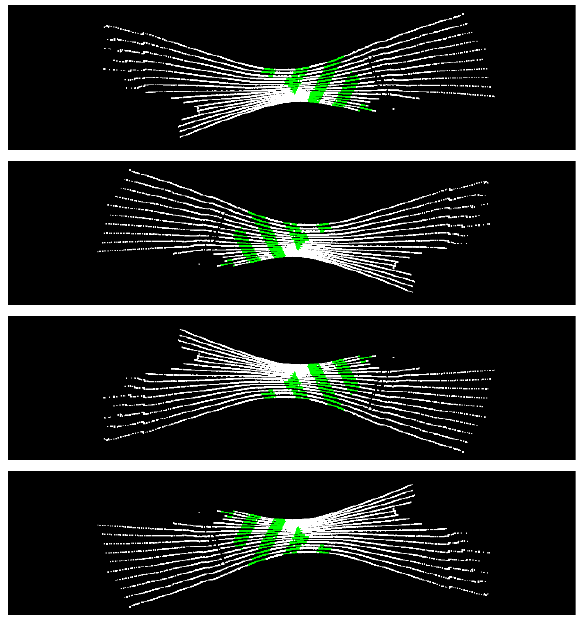
Figure 2. Point Cloud Projection to Top-Down Image.